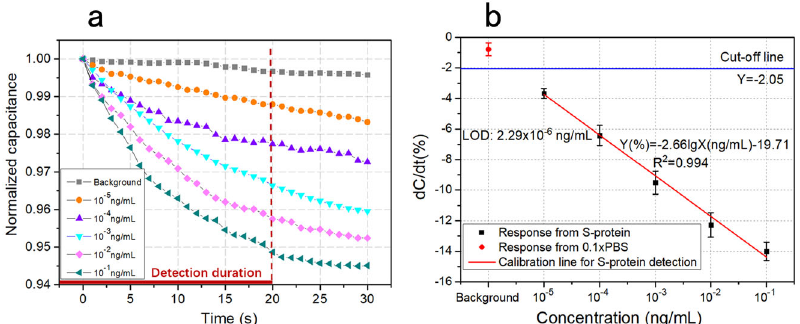
Fig. 3 Response acquired from the immunosenors. a The typical transient capacitance normalized by its initial value changing with time. Five concentrations of S-protein (from 10 − 5 to 10 − 1 ng/mL) as well as the background of 0.1× PBS are continuously detected for 30 s. b Dose response and its calibration. The triplicate data are acquired from three freshly prepared sensors, and the error bar represents the standard deviation.